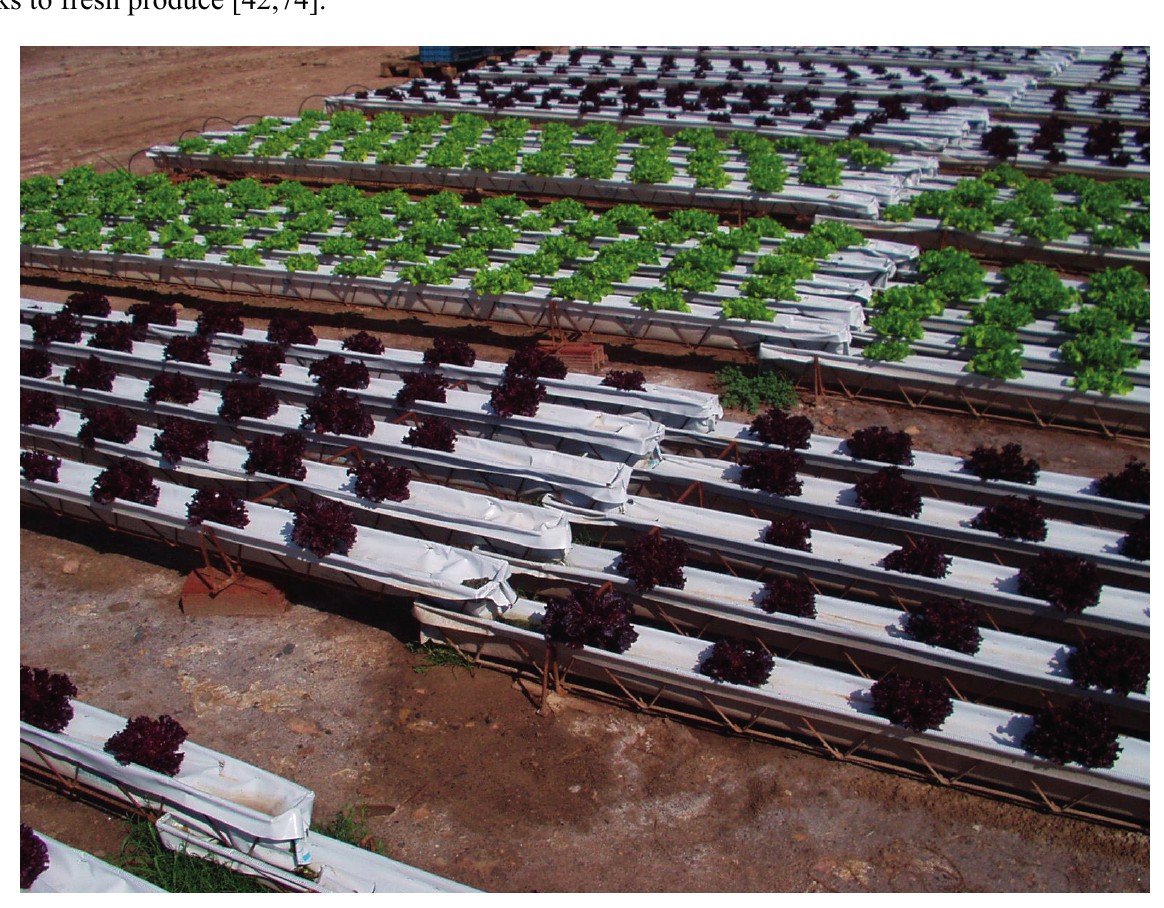
Figure 3. Nutrient film techniques (NFT), a type of soilless systems where a thin film of nutrient solution flows through plastic channels which contain the plant roots and laid on a slope in order to grant the constant flow of nutrient solution. Source: James M. Monaghan (Harper Adams